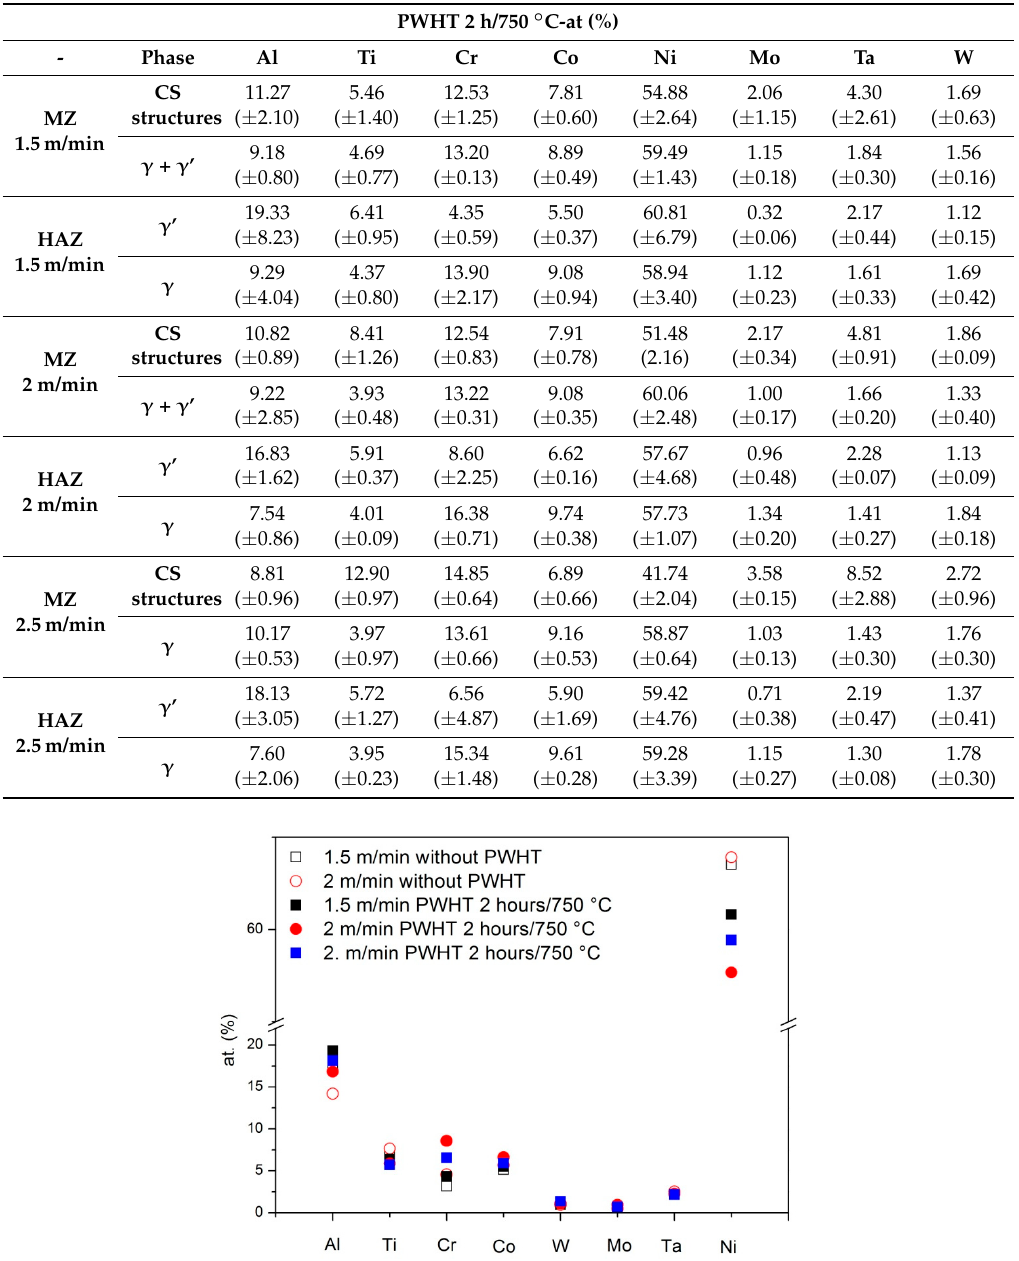
Table 5. EDS data determined on the phases of HAZ and MZ in EB joints with PWHT of 2 h at 750 ◦ C.